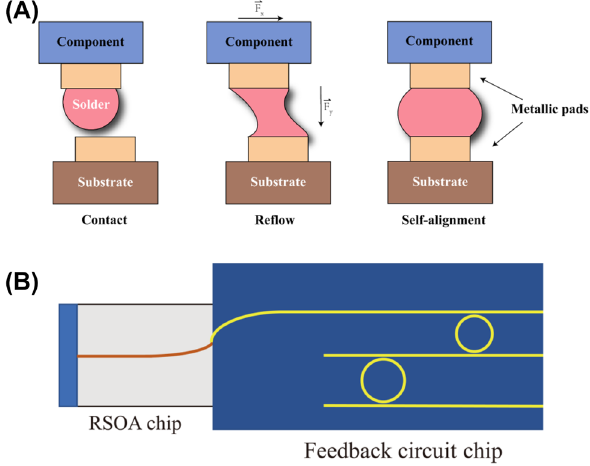
Figure 1: (A) Flip-chip self-alignment of the component and substrate during reflow [18]. (B) In-plane butt-joint coupling